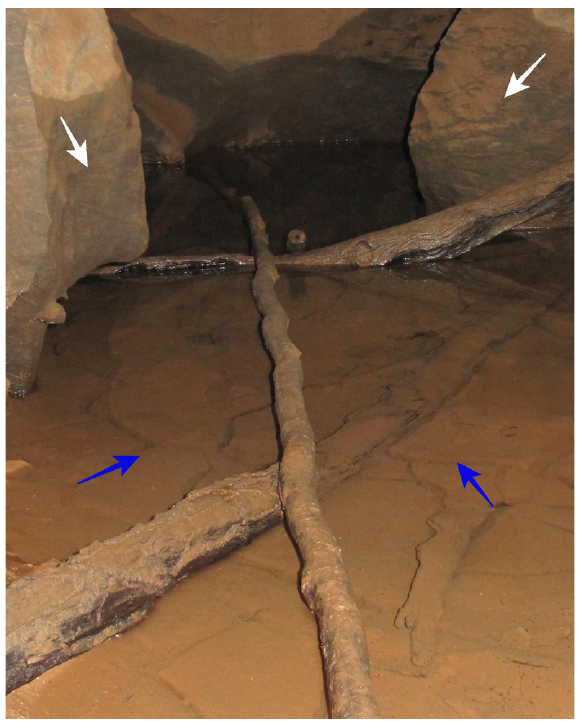
Figure 4. Aquatic microhabitat inside Toca de Candeias, Central, Bahia state, Brazil. Arrows indicate the places on (blue) or adjacent to (white) the water where Paravelia digitata was observed. Photo by M.E. Bichuette.